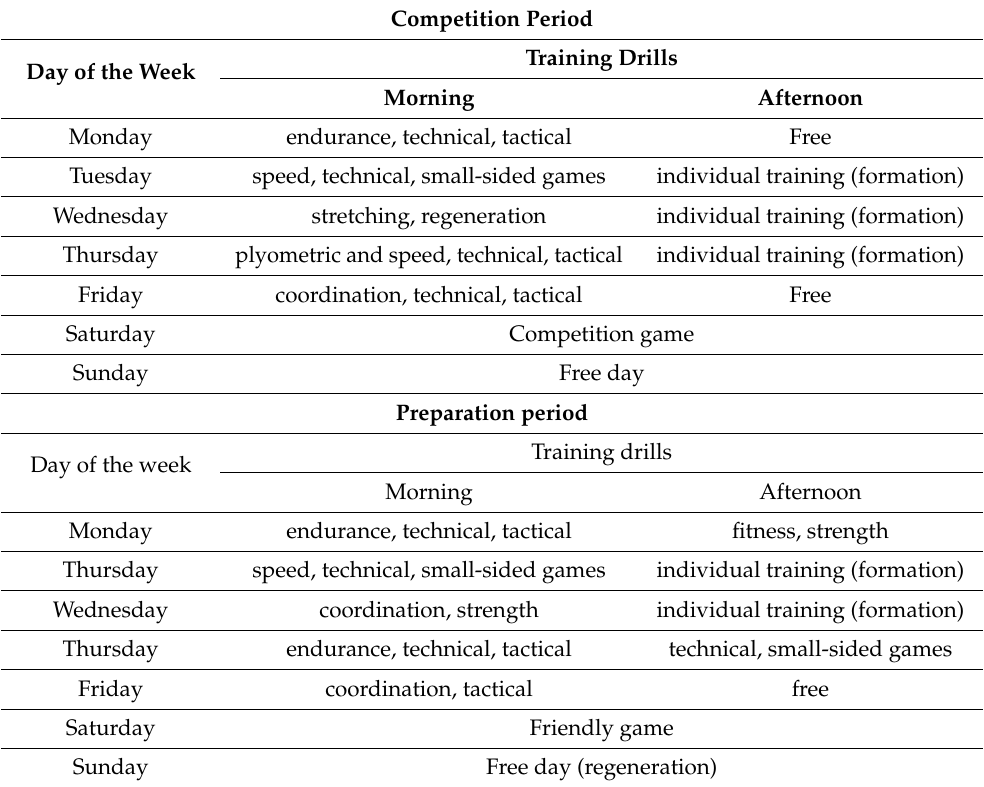
Table 1. Overview of the typical weekly training load during competition and preparation periods of the one-year soccer